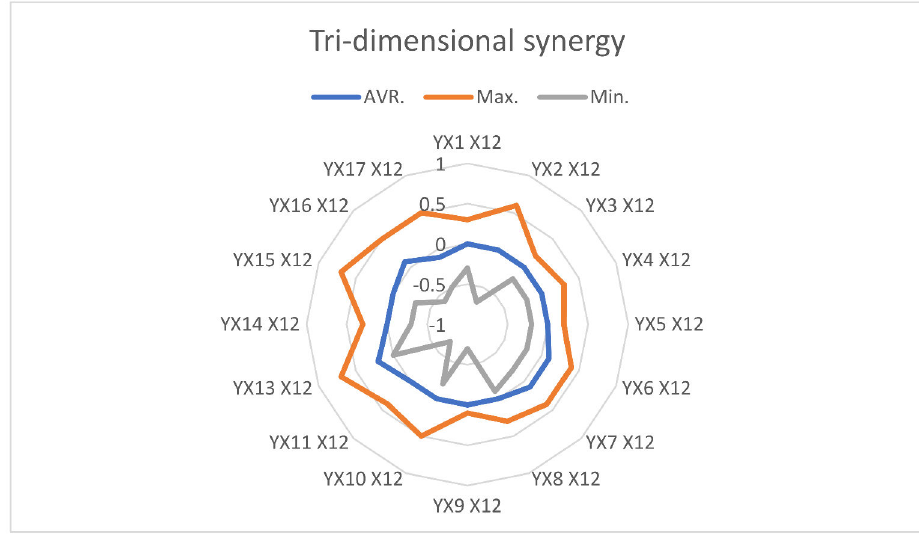
Figure 5. Tri-dimensional synergies in rapport with total training (X 12 ). Source: Authors’